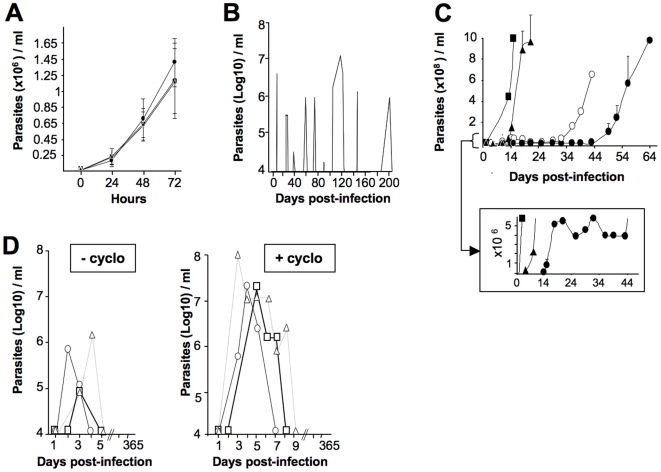

In vitro and in vivo growth characteristics of T. b. gambiense field isolates.A. In vitro culture of Tbg1122, Tbg1166 and Tbg1135 isolates after adaptation to axenic culture conditions. Cultures were seeded with adapted trypanosomes (5.104/ml) in supplemented MEM medium and enumerated every 24 h. The mean trypanosome densities±standard error of the mean of 4 independent cultures is presented. Similar doubling times were obtained with the three isolates (15.9 h, 15.8 h and 14.6 h respectively). B–D. Parasitaemia levels in immunocompetent (BALB/c), immunodeficient (NOD/SCID and cyclophosphamide-treated BALB/c) mice infected with the different field isolates. Parasitaemia was measured from tail-blood either by direct observation of the wet films under the microscope or by using a haemacytometer. The limit of detection was estimated at about 104 parasites/ml. B. Represents the results of one representative BALB/c mouse (n = 6) infected i.p. with 106 of the Tbg945 blood isolate. All infected mice showed successive waves of parasitaemia and died within 6–8 months PI. C. Represents the mean parasitaemia in NOD/SCID mice infected with 103
Tbg1122c (n = 4), Tbg1166c (n = 6), Tbg1135c (n = 9) or Tbg1135b (n = 10) isolates. D. Represents the results of one representative BALB/c mouse infected with 1–5×106
Tbg1122b, Tbg1166b (n = 10) or Tbg1135b blood (n = 6) isolates with (+cyclo) or without (−cyclo) prior administration (24 h before infection) of cyclophosphamide (200 mg/kg). Solid symbols indicate culture isolates, open symbols indicate blood isolates of Tbg1166 (▴ , ▵), Tbg1122 (▪ , □) and Tbg1135 (• , ○).